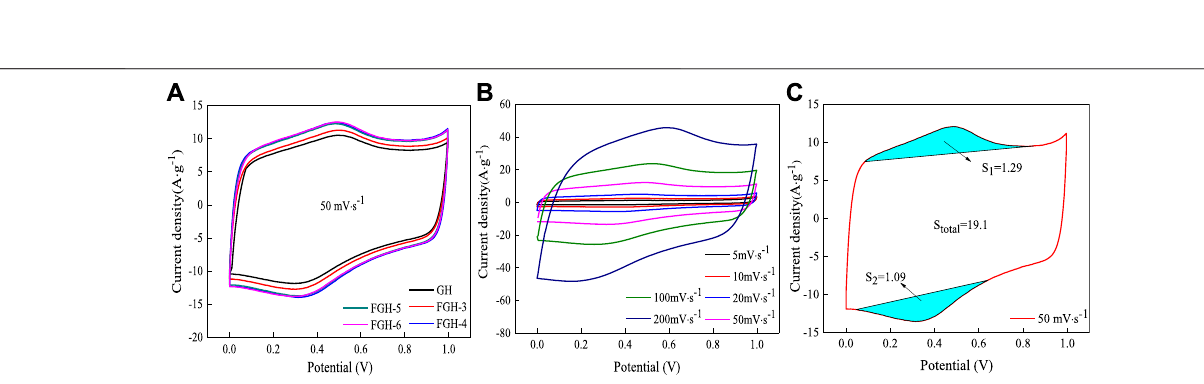
FIGURE 4 | SEM images of (A) GO, (B) GH, (C) FGH-3, (D) FGH-4, (E) FGH-5, and (F) FGH-6.